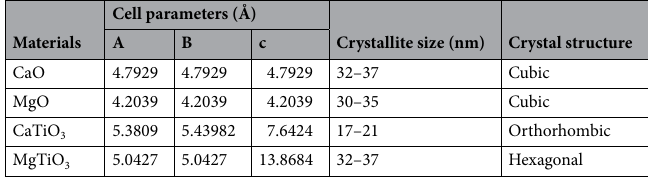
Cell parameters Materials